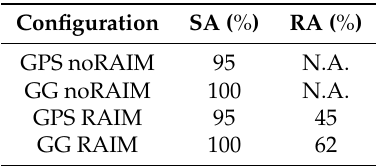
Table 6. SA and RA of the velocity